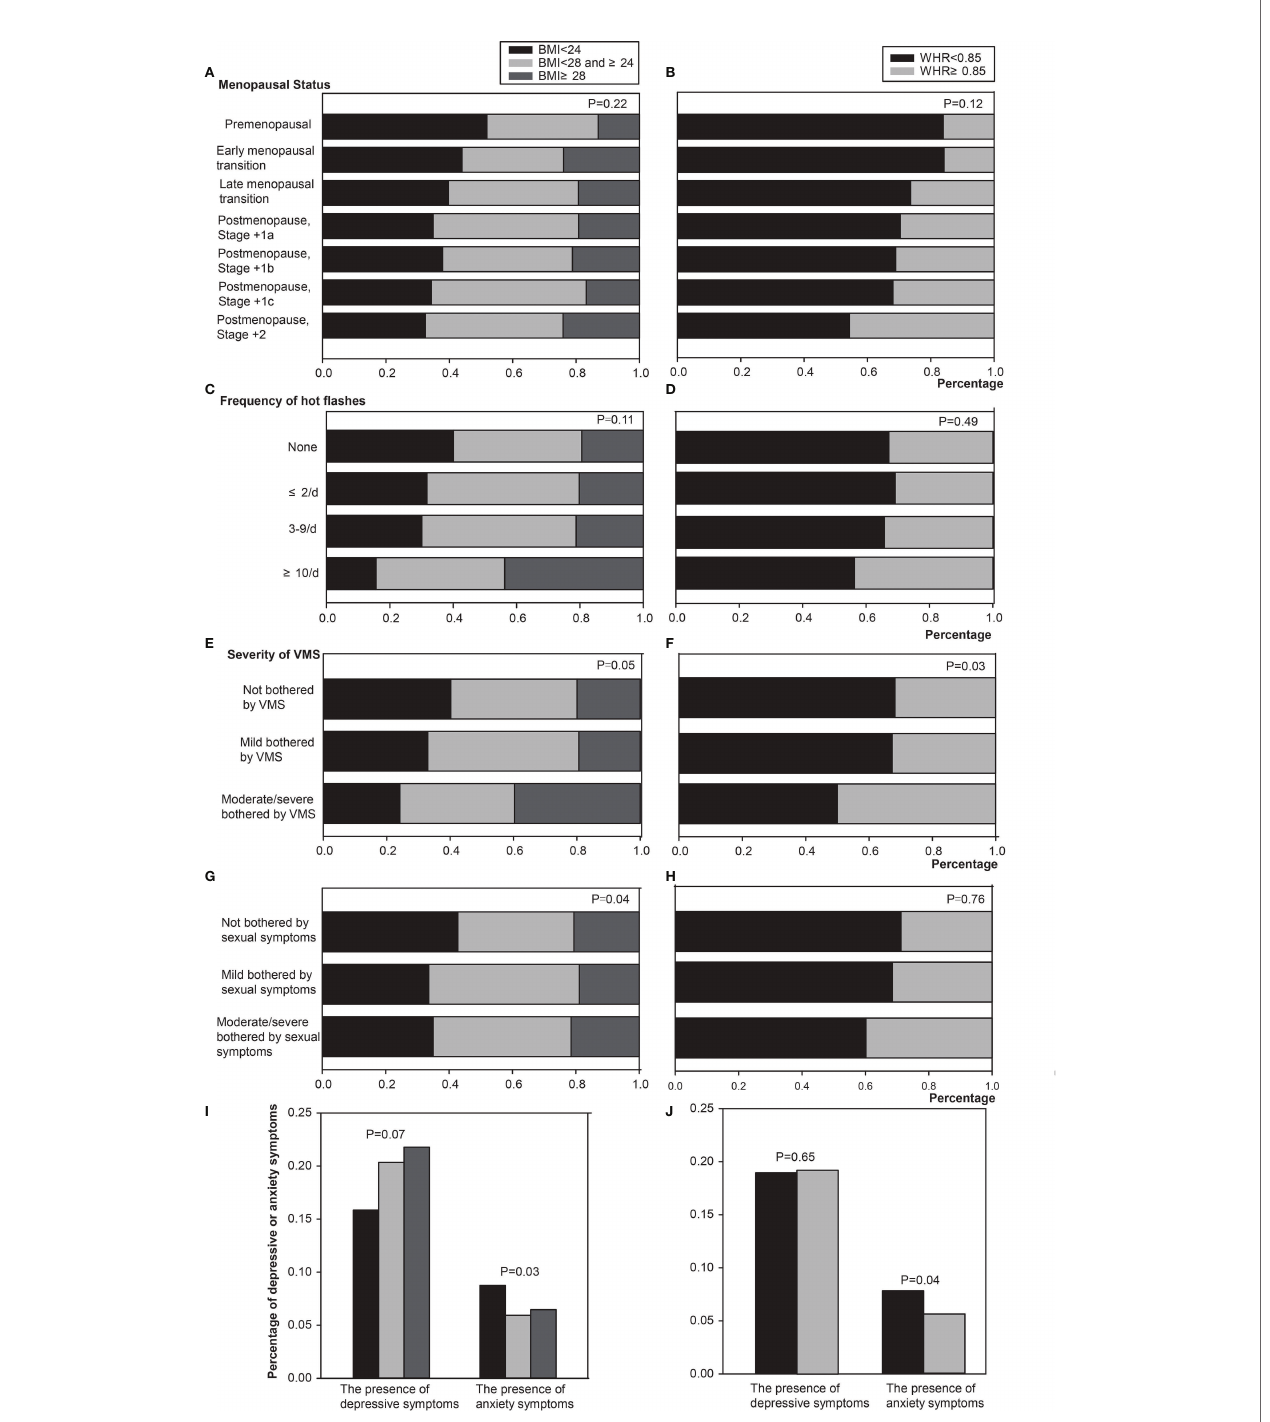
FIGURE 1 | Relationship between obesity or abdominal obesity and menopausal symptoms. The P values were estimated by generalized estimating equations used for repeated measures. (A) The relationship between menopausal stage and obesity. (B) The relationship between menopausal stage and abdominal obesity. (C) The relationship between frequency of hot fl ashes and obesity. (D) The relationship between frequency of hot fl ashes and abdominal obesity. (E) The relationship between severity of VMS and obesity. (F) The relationship between severity of VMS and abdominal obesity. (G) The relationship between sexual symptoms and obesity. (H) The relationship between sexual symptoms and abdominal obesity. (I) The relationship between depressive or anxiety symptoms and obesity. (J) The relationship between depressive or anxiety symptoms and abdominal obesity. BMI, body mass index; WHR, waist-to-hip ratio; VMS, vasomotor